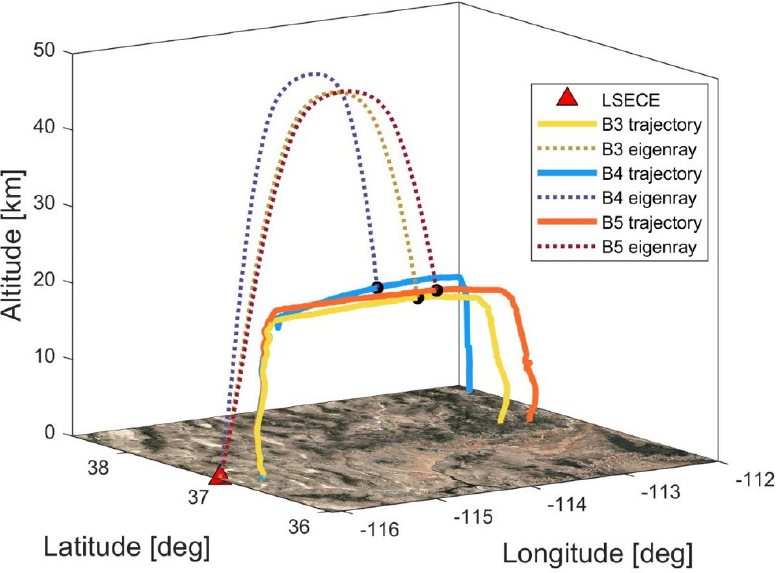
Figure 10. Raytracing results. Plotted are the eigenrays consistent with the observed arrival times of the first phase at all three floating sensors. The source is shown by the red triangle.